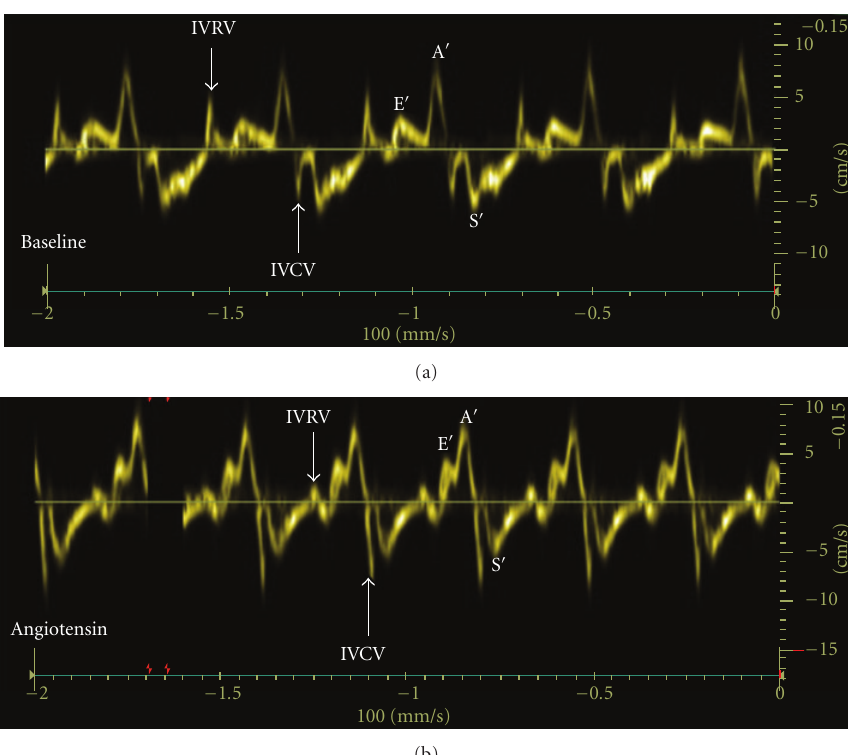
Figure 2: Tissue Doppler-derived left ventricular longitudinal myocardial velocities at the level of mitral valve annulus at baseline (a) and during angiotensin II infusion (b). Note an increase in myocardial isovolumic contraction (IVCV) and early ventricular filling (E (cid:3) ) velocities and a decrease in myocardial isovolumic relaxation velocity (IVRV) during angiotensin II infusion.